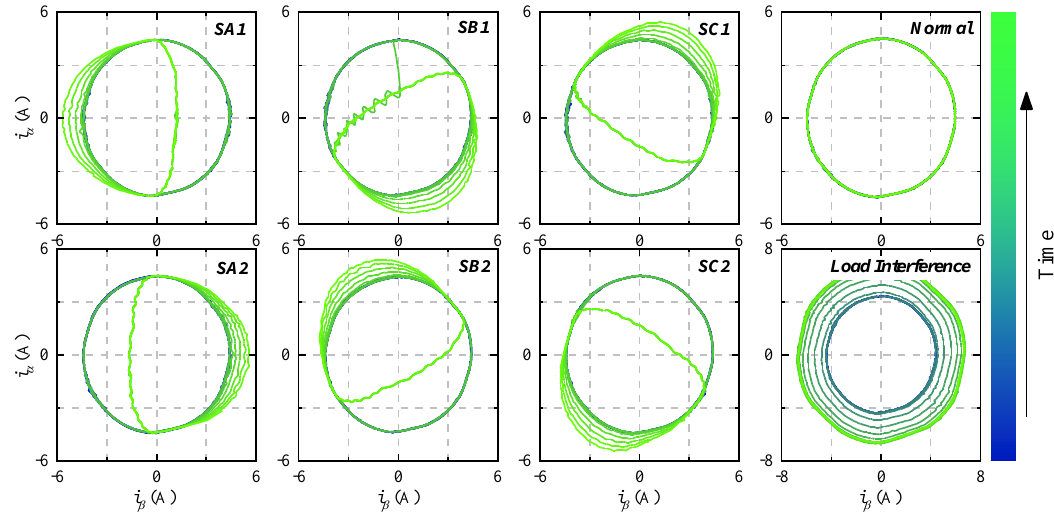
Figure 7. Input current features in a two-phase coordinate system under eight conditions.